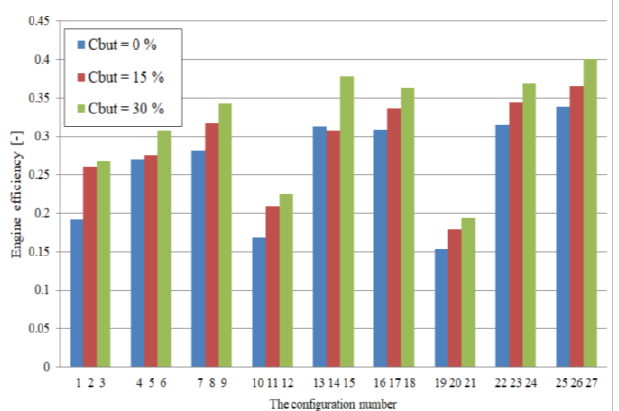
Fig. 3. Comparison of the engine efficiency for the engine fed with blend n-butanol fuel and